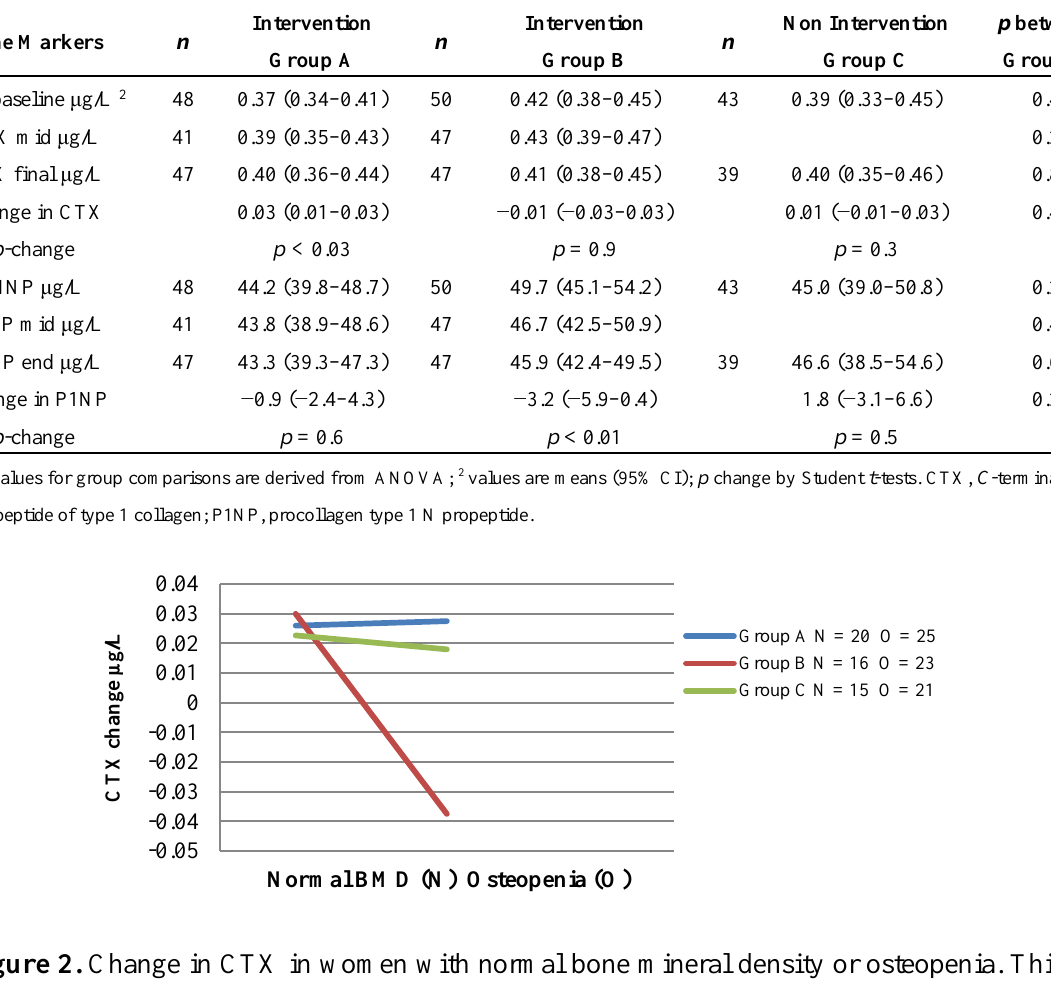
Figure 2. Change in CTX in women with normal bone mineral density or osteopenia.